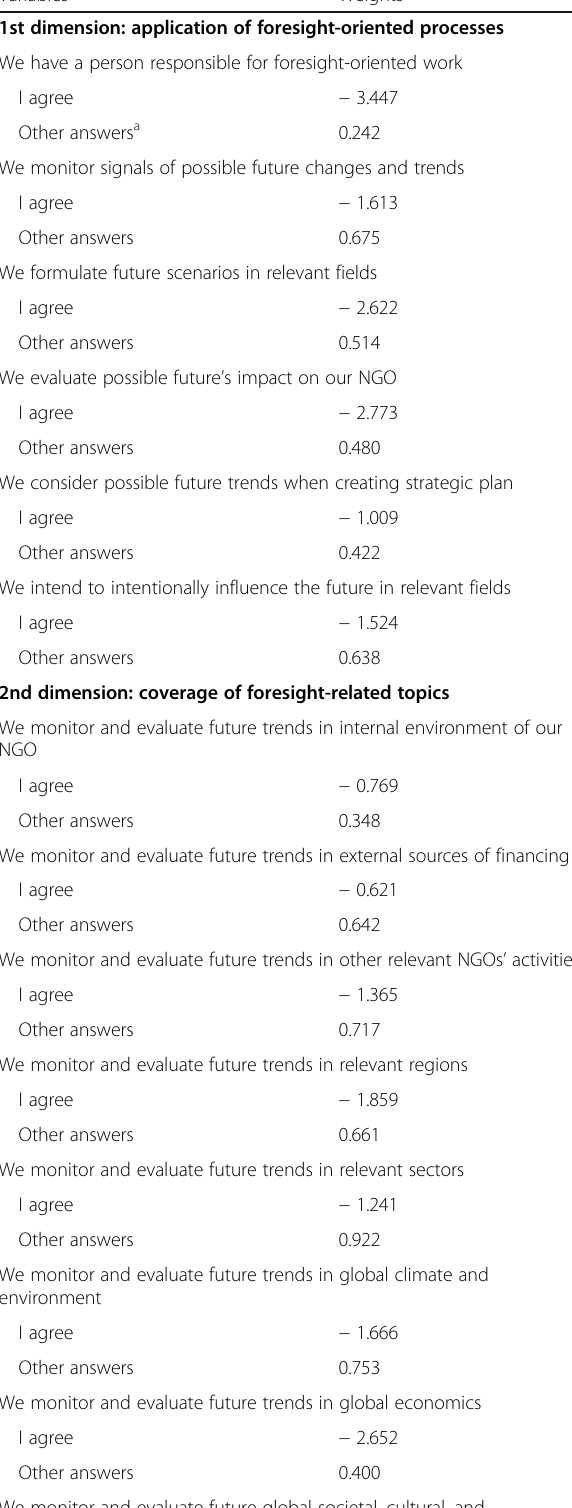
Table 1 Structure of the Foresight Orientation Ratio (FOR)